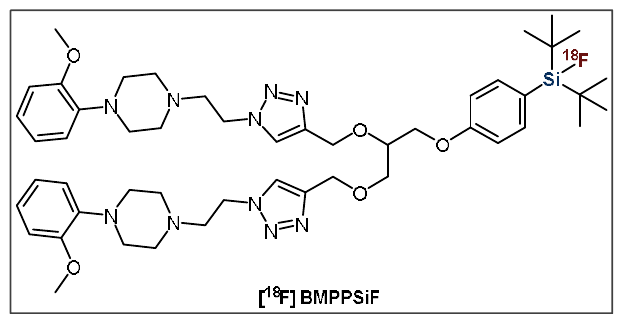
Figure 12. General structure of bivalent radioligand, [ 18 F]BMPPSiF.